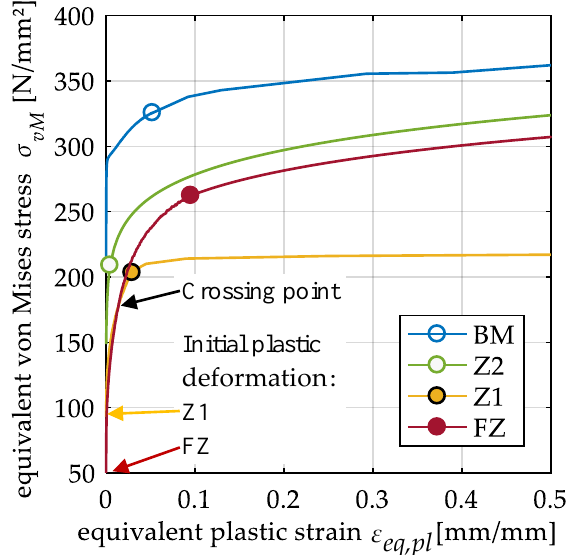
Figure 1. Hardness test after welding and natural ageing in the plate center [16].